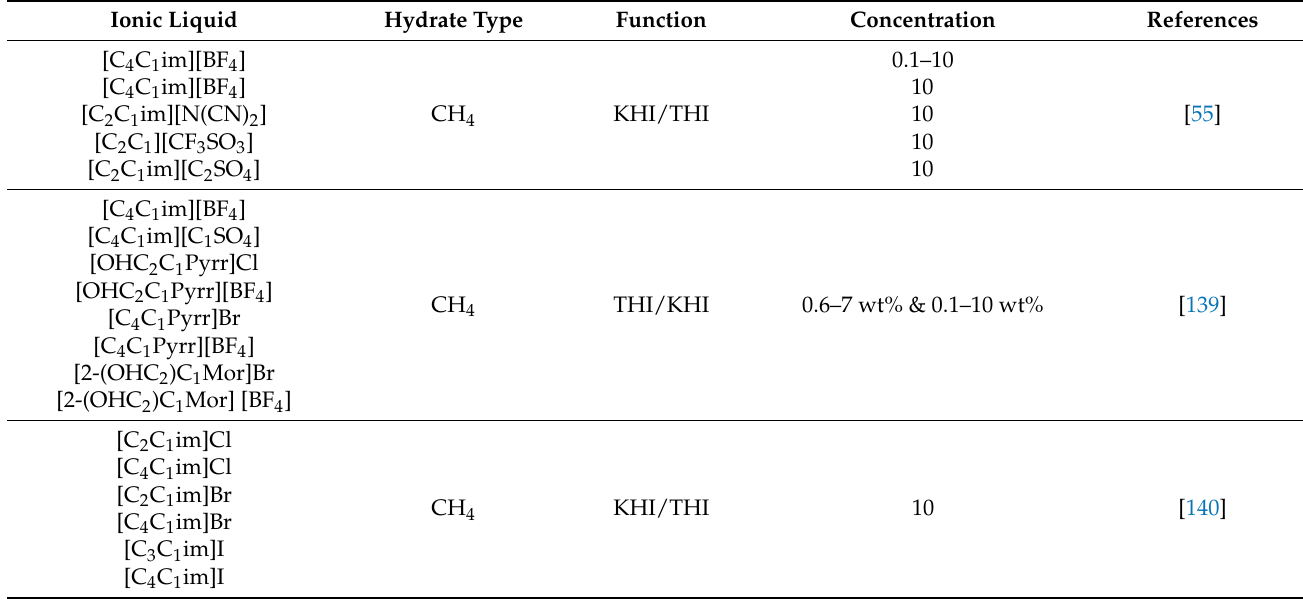
Table 7. Summary of ionic liquids used as a dual function hydrate inhibitors in oil/gas